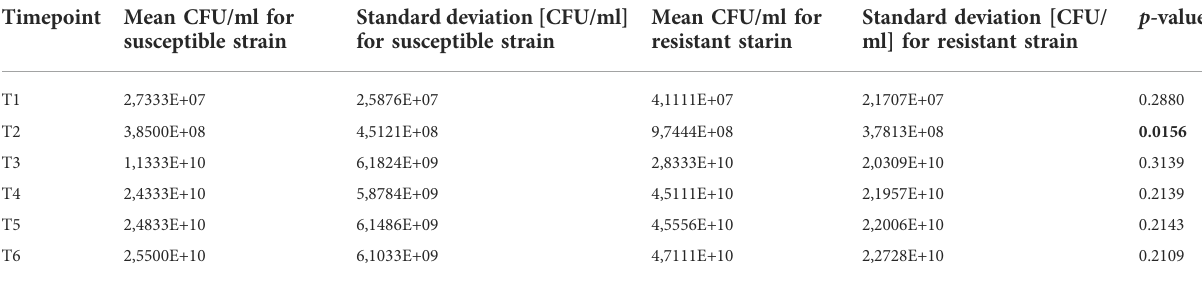
TABLE 1 Statistical comparison of proliferation rate between susceptible and resistant strains of Klebsiella pneumonia. Timepoint Mean CFU/ml for susceptible